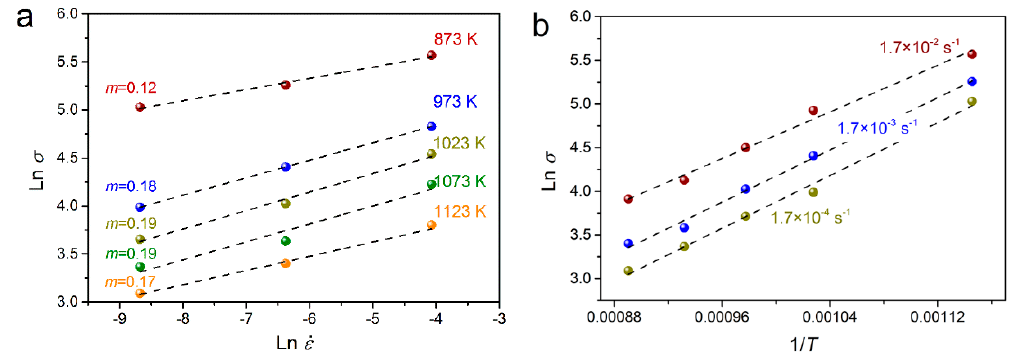
. ε ( a ) and ln σ –1 / T ( b ) for the 0Cr18AlSi